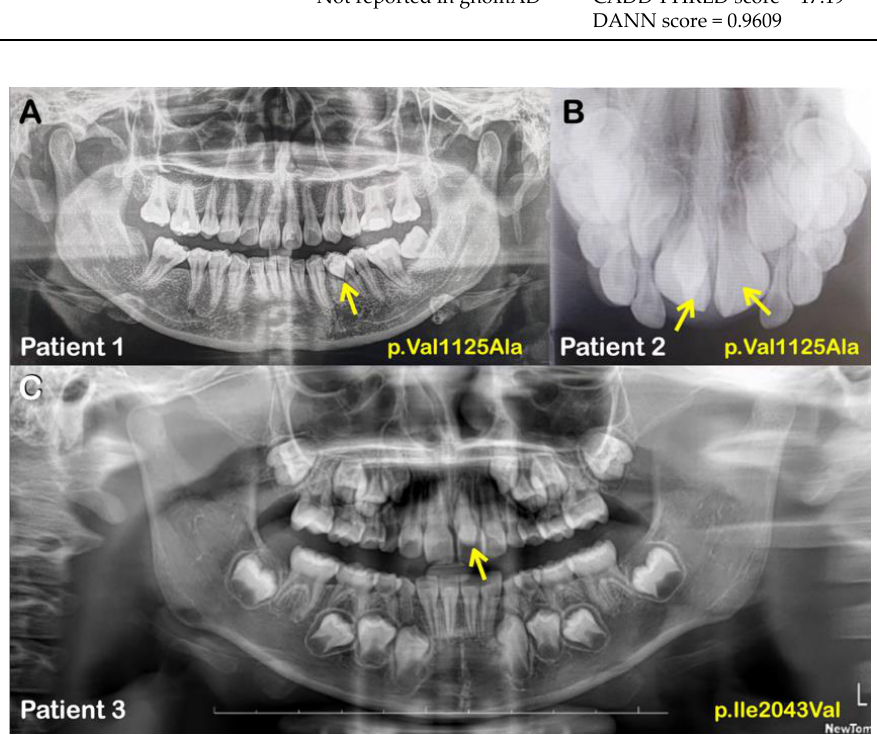
Figure 1. ( A ) Patient 1. Panoramic radiograph showing a supernumerary left mandibular premolar (arrow). ( B ) Patient 2. Occlusal radiograph showing double mesiodentes (arrows). ( C ) Patient 3. Panoramic radiograph showing a mesiodens (arrow).